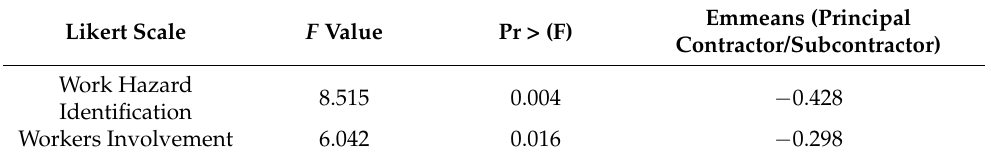
Emmeans (Principal